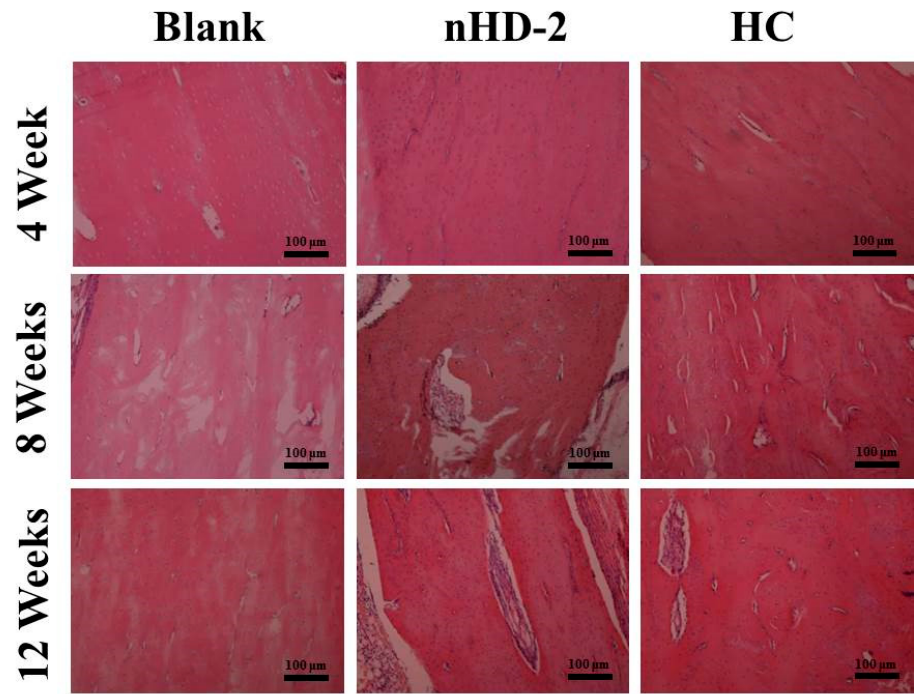
Figure 10. Images of H&E staining in New Zealand rabbits tissue surrounding the radius defect site after 4, 8 and 12 weeks of nHD-2 scaffolds’ and HC scaffolds’ repairs, respectively. The scale bar is 100 μ m.